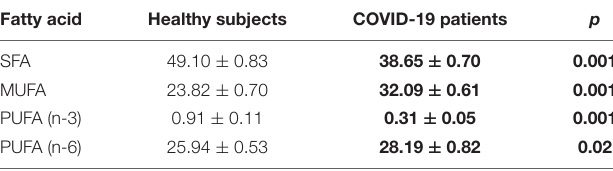
TABLE 4 | Total fatty acid composition of saturated, monounsaturated, and polyunsaturated in the plasma from the healthy subjects and COVID-19 patients.